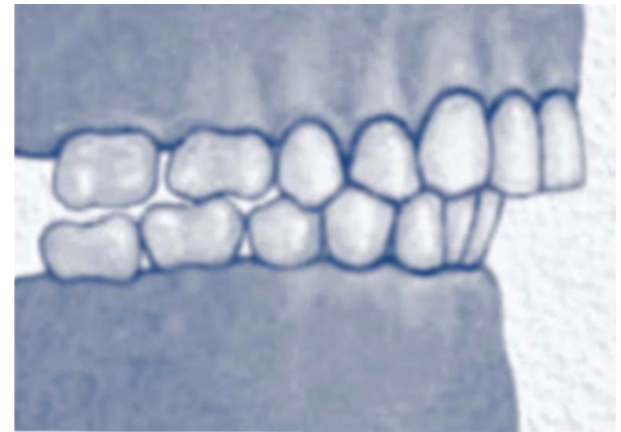
Figure 2 Class II dental occlusion (Angle).